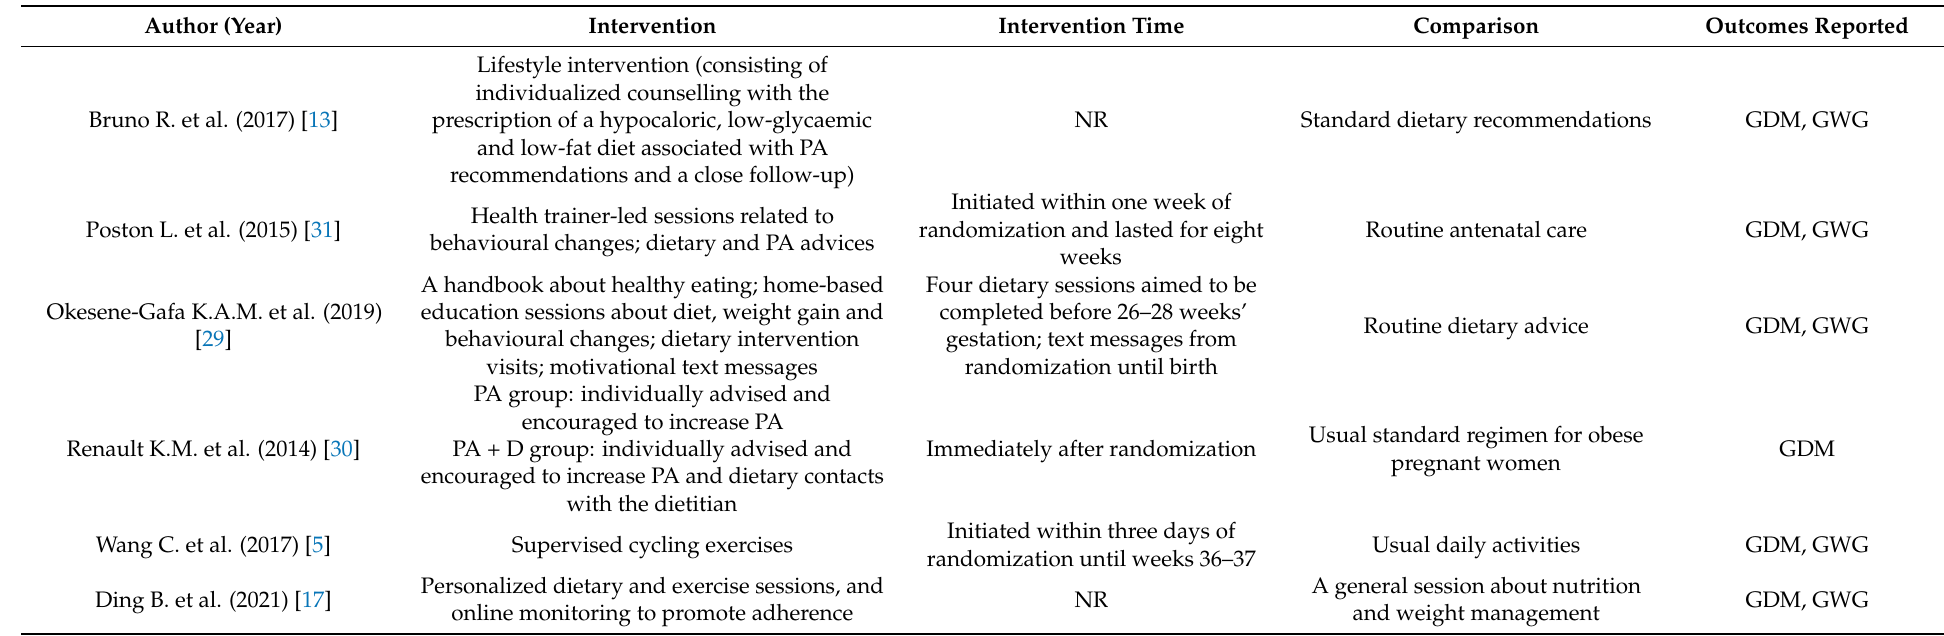
Table 2. Protocol and outcomes definition in the included